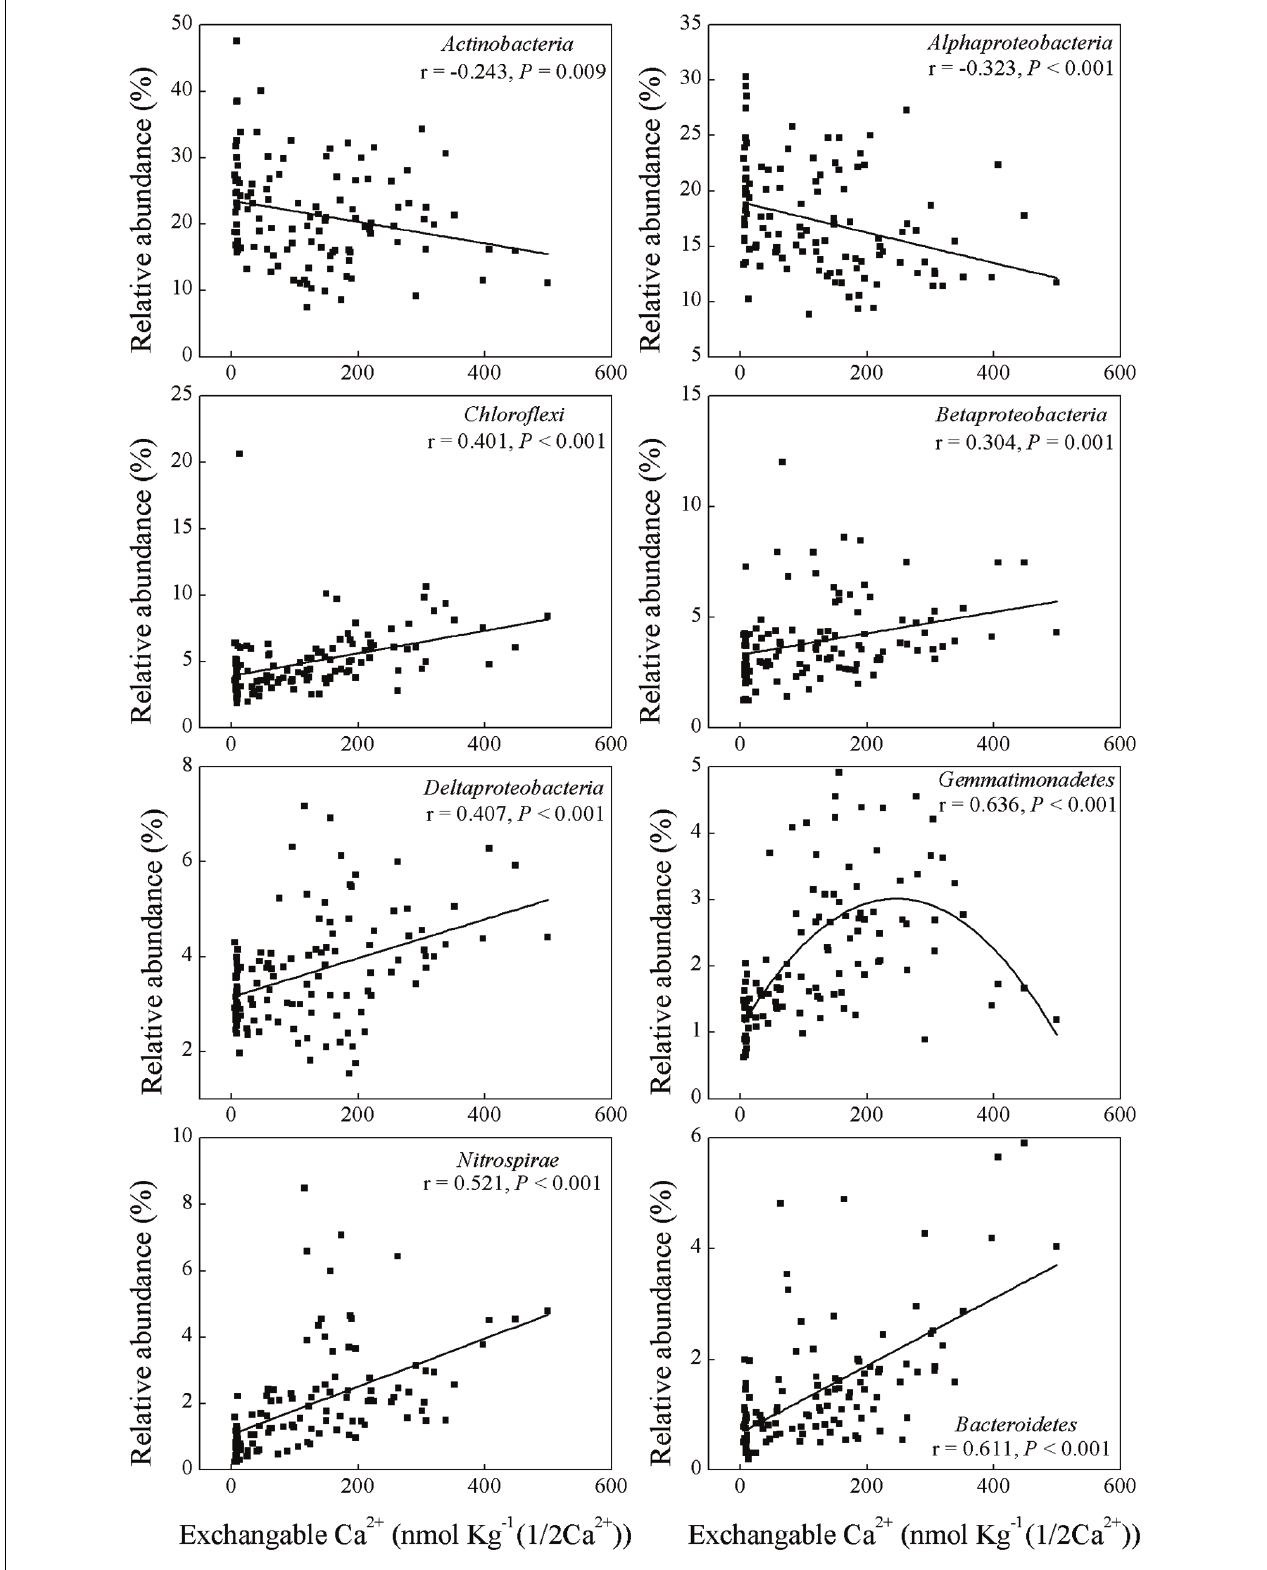
FIGURE 3 | Relationships between the relative abundance of dominant bacterial groups and soil exchangeable Ca 2 + content.